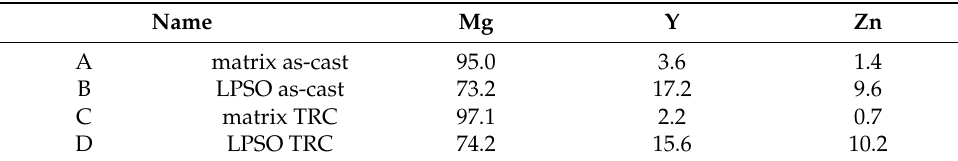
Figure 3. Results of the X-ray diffraction analysis (XRD) of the homogenized (500 °C, 2 h) Mg-6.8Y- 2.5Zn-0.4Zr alloy after conventional and after twin-roll casting .